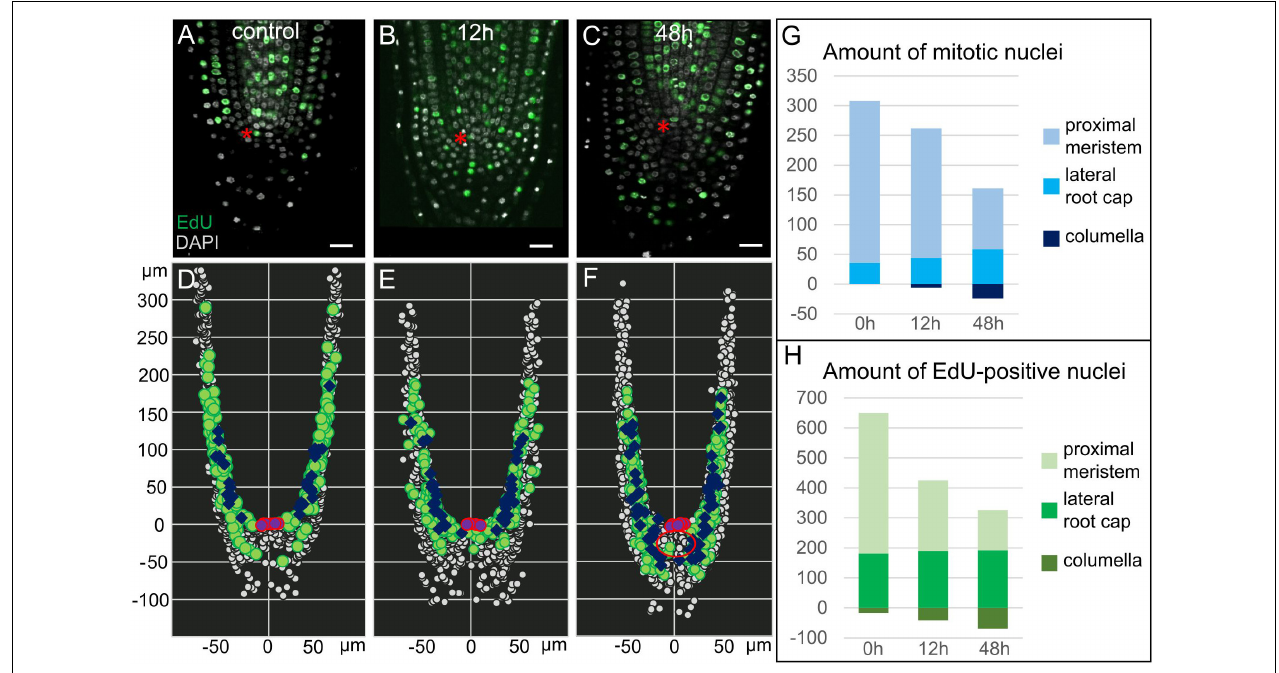
FIGURE 2 | Proliferation activity in 35S:WOX5-GR root tips. (A–F) Distribution of mitotic, S-phase, and interphase nuclei in 35S:WOX5-GR root tips at 0 (A,D) , 12 (B,E) , and 48 h (C,F) of DEX exposure. (A–C) Confocal images of EdU/DAPI labeled root tips. EdU-positive green color marks nuclei undergoing S-phase, highly dense white color marks mitotic nuclei, shallow light gray marks interphase nuclei. The bar scale – 20 µ m. The QC location is marked by the red asterisks. (D–F) 3D maps built upon (A–C) with iRoCs Toolbox (Schmidt et al., 2014). Nuclei are presented as gray dots. EdU-marked cells and mitoses are displayed as green circles and dark blue rhombuses, respectively, interphase nuclei are small dots. QC cells are shown by the magenta circles. (G,H) Quantitative analysis of 3D maps for mitotic (G) and EdU-positive nuclei (H) distribution in the 35S:WOX5-GR root tips at 0, 12, and 48 h of DEX exposure. The full data is given in